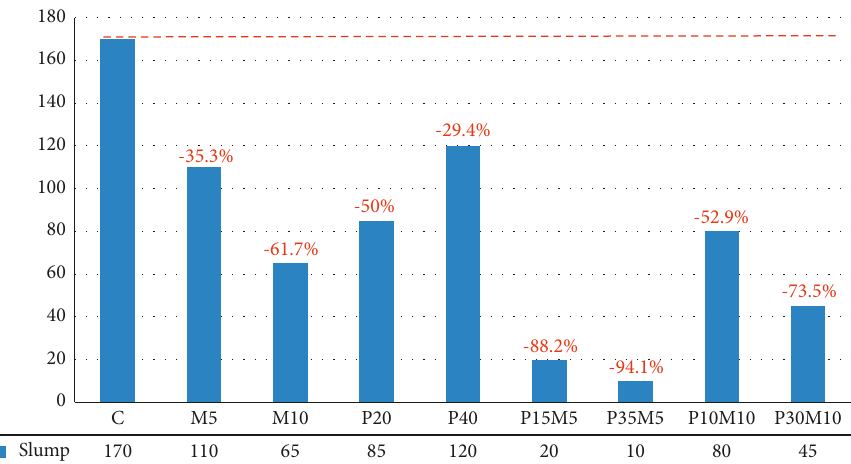
Figure 6: Concrete slump test